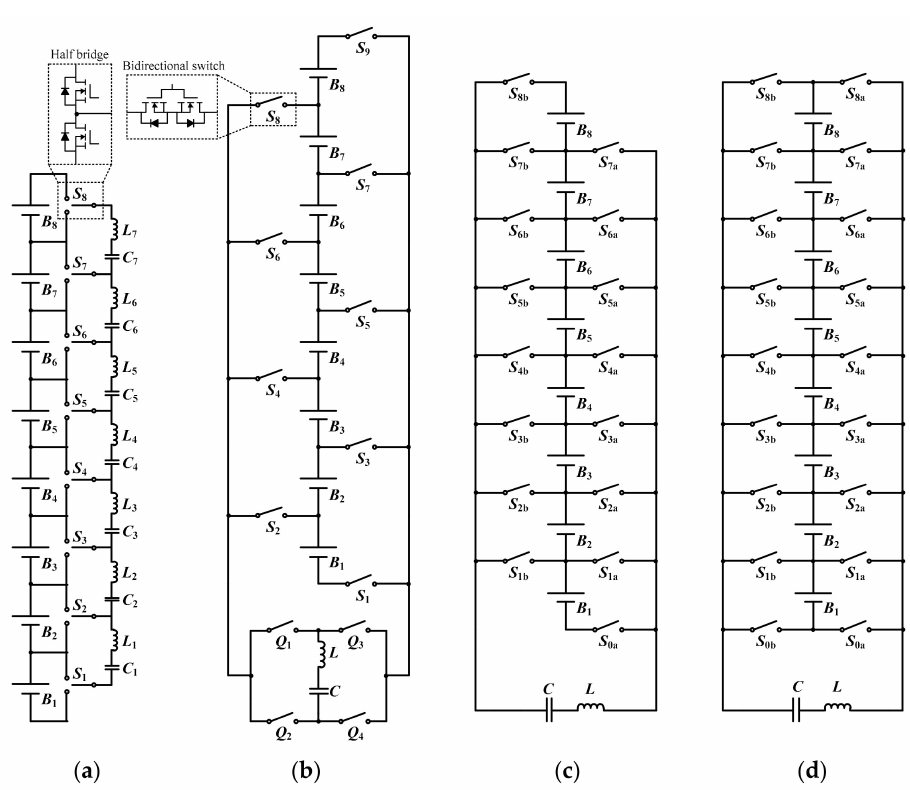
Figure 10. Circuit comparison of different equalizers for 8 cells. ( a ) AC2C equalizer based on QRSCC. ( b ) DC2C equalizer based on LCSRC. ( c ) MC2MC equalizer based on HBLCC. ( d ) Proposed MC2MC equalizer based on